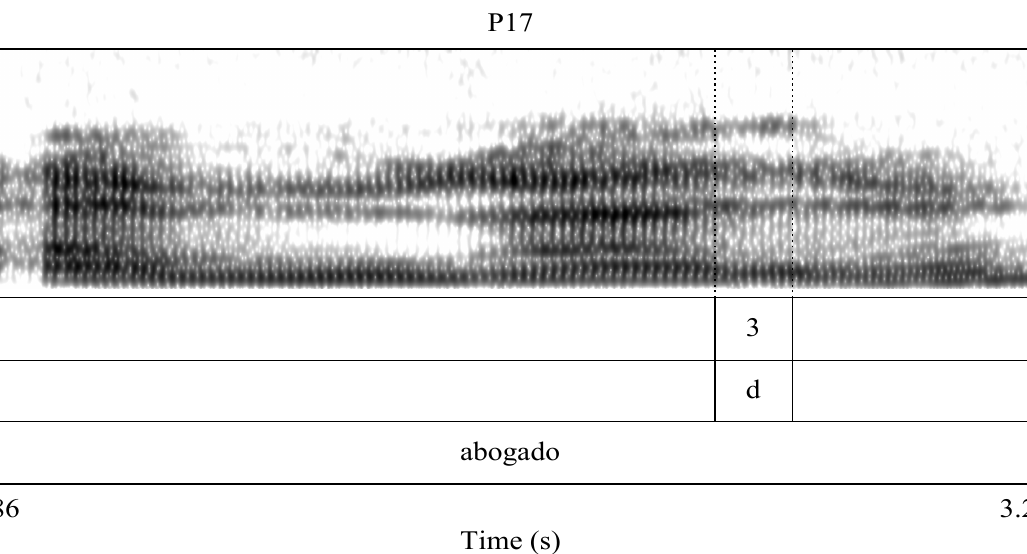
Figure 1. /d/ segment with a score of 1 (occlusive).